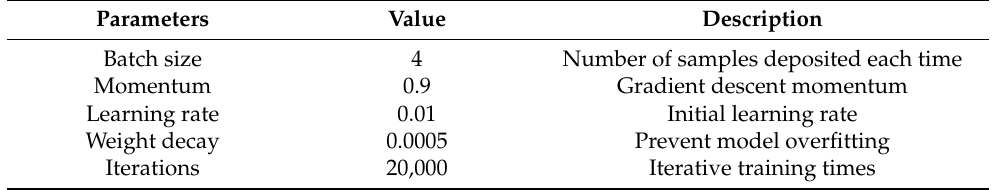
Table 1. Experimental parameter table. Parameters Value